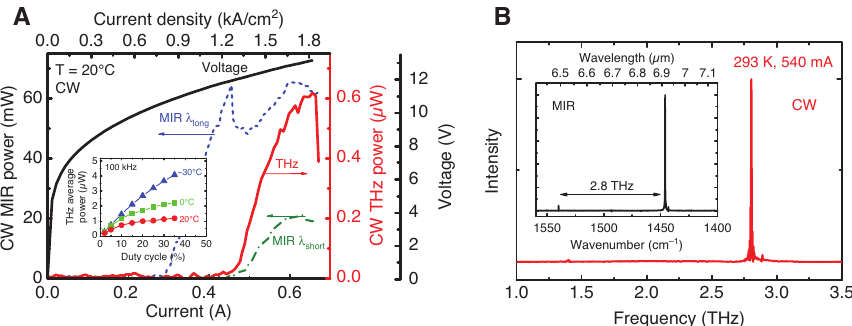
Figure 13: Room temperature CW performance of the CW THz DFG-QCL. (A) Room-temperature current-voltage-light (I-V-L) output characteristics of the mid-IR (dashed lines, bottom and left axis) and THz emission (solid red line, bottom and right axis) measured in the CW mode. Inset: average power as a function of the duty cycle. (B) Room-temperature CW THz emission spectrum, taken at a current of 0.54 A. The inset shows room-temperature mid-IR emission spectrum of the device in the CW